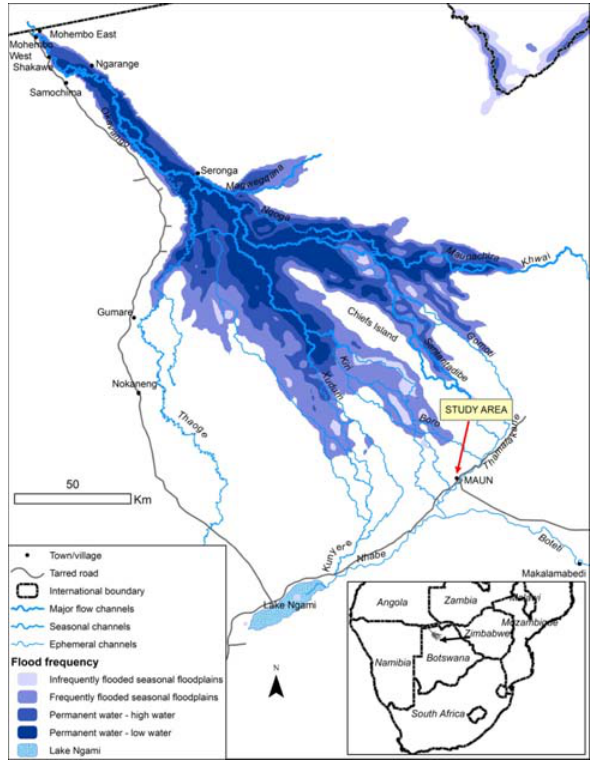
Figure 1. Study area around Maun on southern end of Okavango Delta